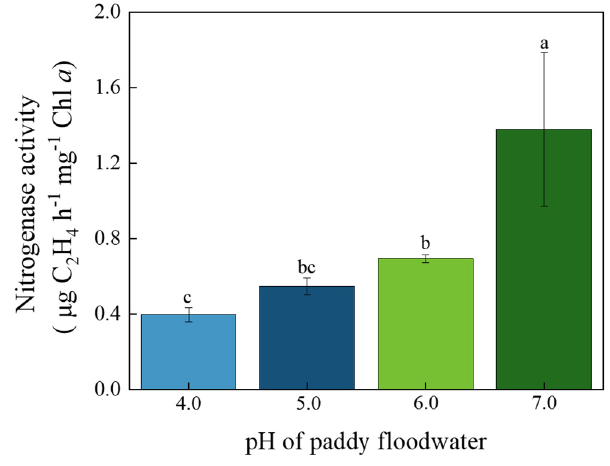
Figure 5. Effects of paddy floodwater acidification on N 2 fixation rate of Aliinostoc sp. YYLX235. Different letters indicate statistically significant at p < 0.05 (one-way ANOVA, LSD).